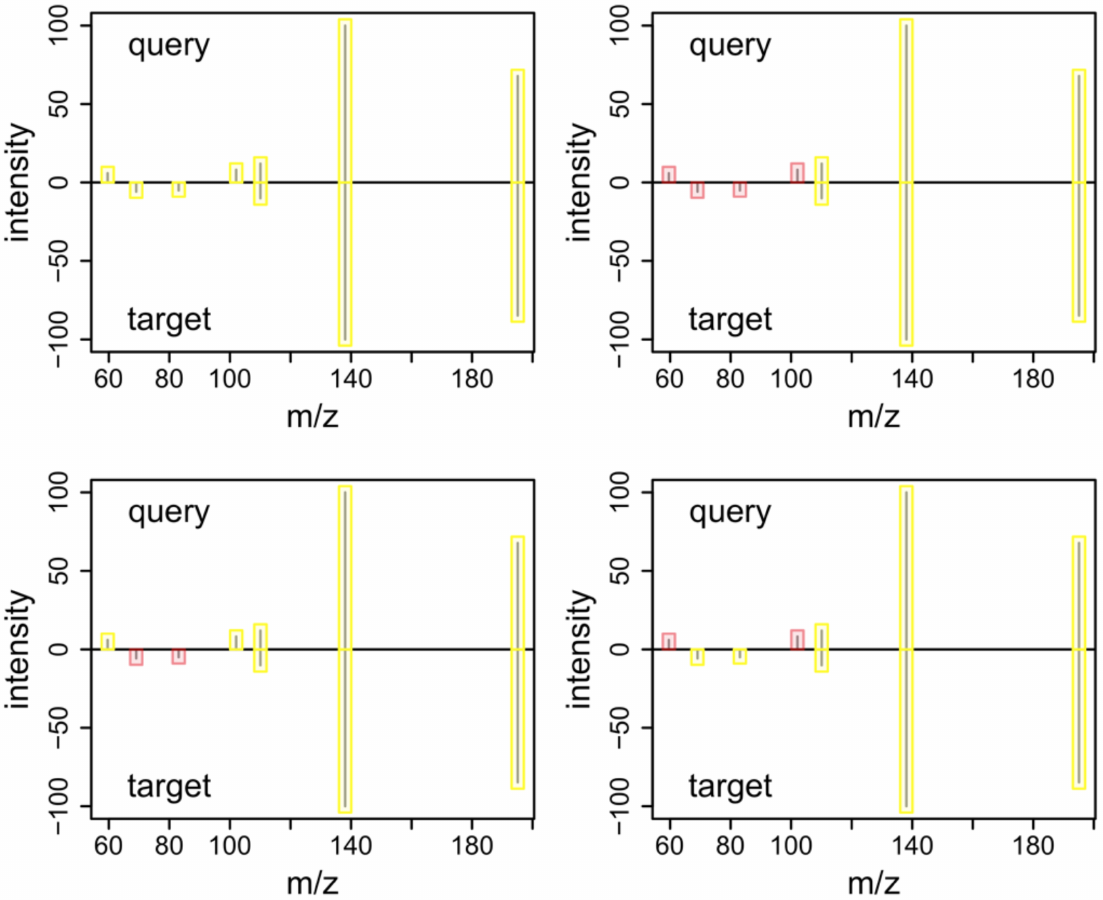
Figure 2. Peak mapping strategies of the joinPeaks() function. Peaks returned by the joining strategy are highlighted in yellow, those not considered in red. Mapping strategies are named according to the join terminology in SQL. Top left: the outer join option reports all peaks from both spectra. Top right: the inner join reports only matching peaks from both spectra. Bottom left: the left join option includes all peaks from the query spectrum and matching peaks from the target spectrum. Bottom right: the right join includes all peaks from the target spectrum and only matching peaks from the query